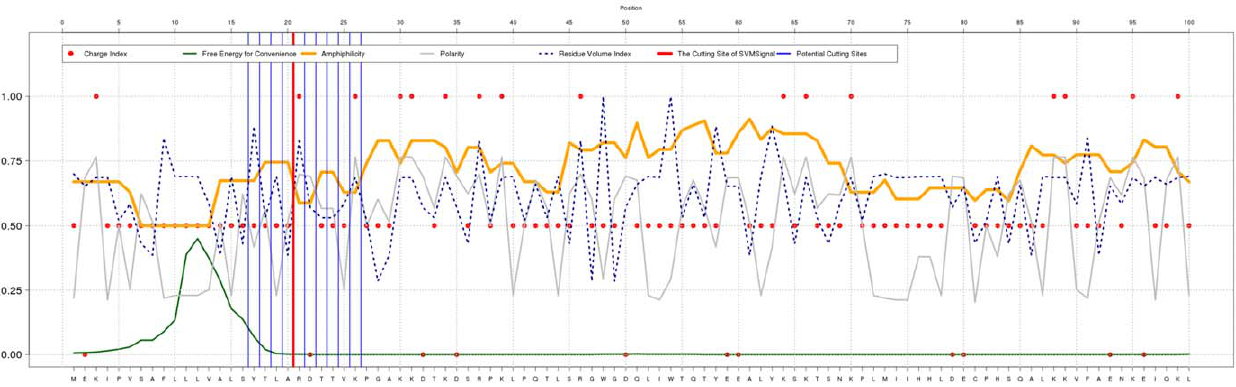
Figure 2. An example, O95994 (AGR2_HUMAN), of biochemical feature profiles in a 100-residue N-terminal subsequence predicted to contain a signal